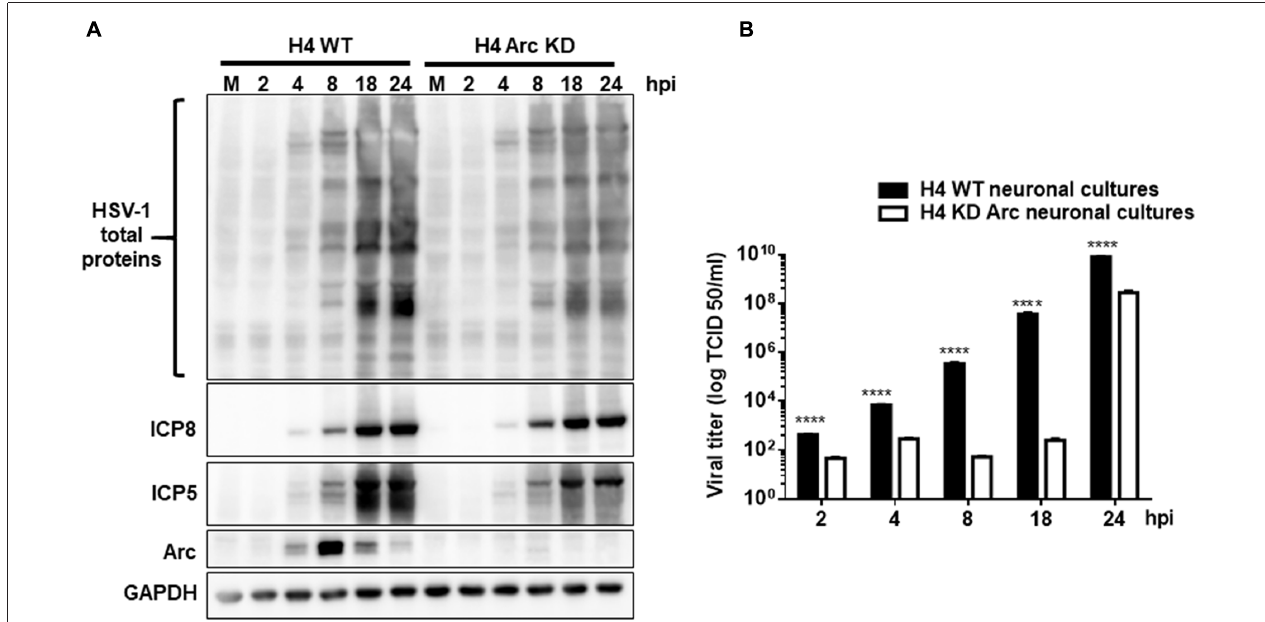
FIGURE 9 | Arc enhances HSV-1 viral progeny in vitro . (A) H4 cells stably expressing either the shRNA to luciferase (H4 shRNA-Luc) used as a control or the shRNA to Arc (H4 shRNA-Arc) to achieve silencing of Arc KD were infected with HSV-1 (MOI = 10) during 2, 4, 8, 12, 18 y 24 hpi. First, infected cells were harvested and the production of infectious viral progeny in the supernatants measured in each time point by a standard TCID 50 assay. Second, total protein extracts were analyzed by immunoblot with antibodies to the proteins ICP8, ICP5, Arc and GADPH. (B) Graphic shows the viral titer of HSV-1 in the supernatants from H4 shRNA-Luc (black bars) or H4 shRNA-Arc (white bars). The results shown are representative of three independent experiments ( ∗∗∗∗ p > 0.0001, analyzed by two-way